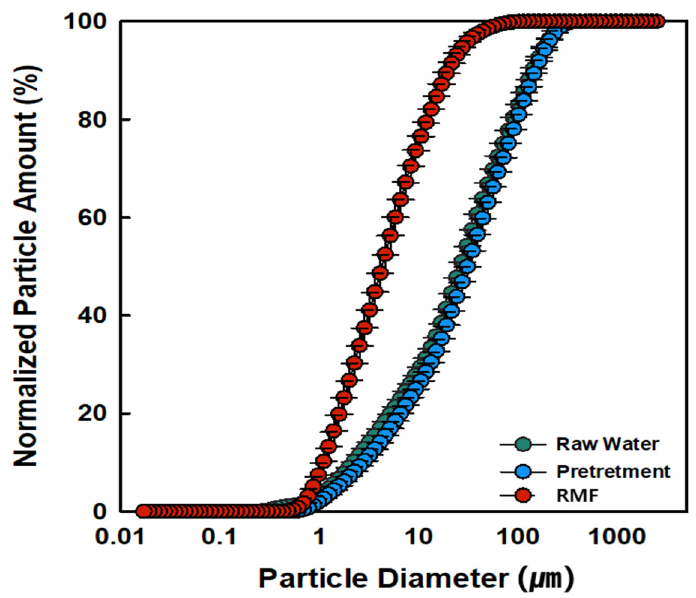
Figure 4. Particle size analysis of multifiber media filtration.